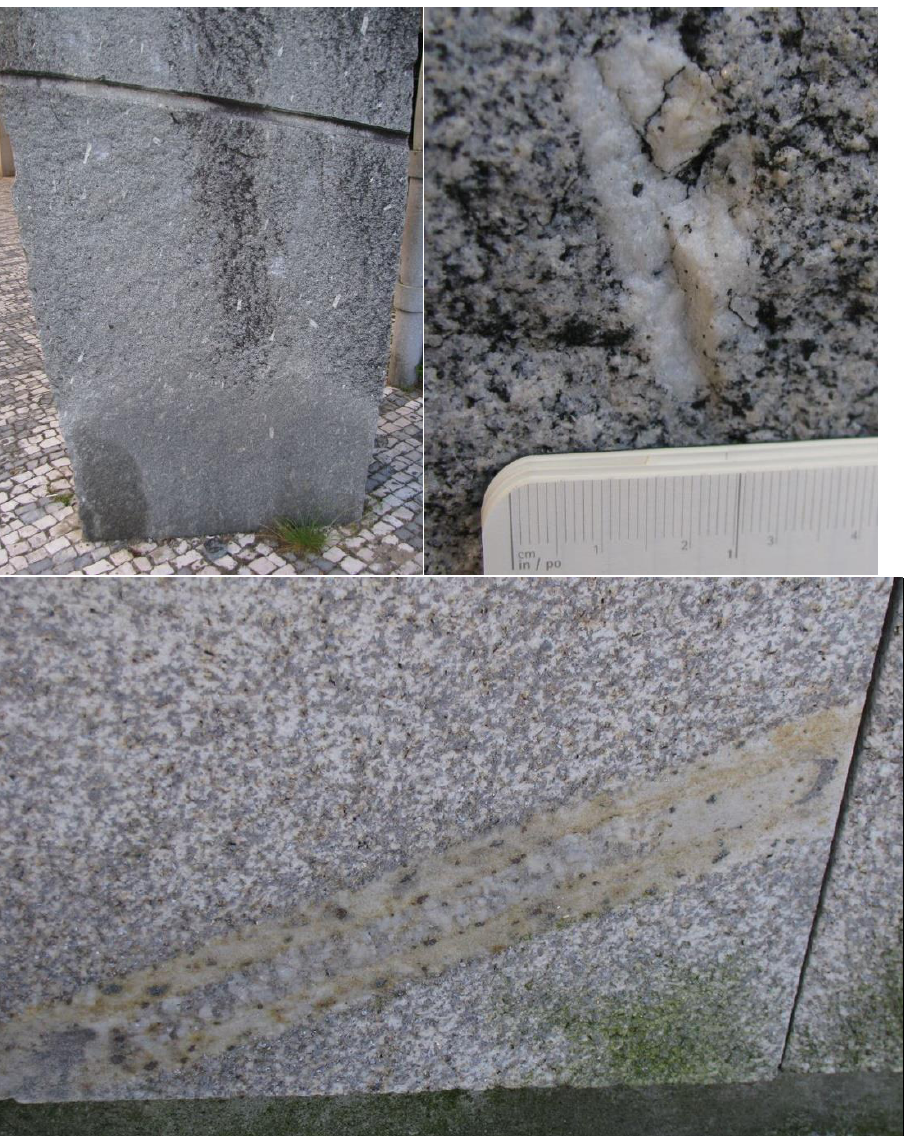
Figure 2. Examples of features of geological interest (FGIs) in built environment: biotitic porphyric granite (upper left hand); twinning on feldspar (upper right hand); aplite-pegmatite textures in a veinlet of a two-mica granite (lower